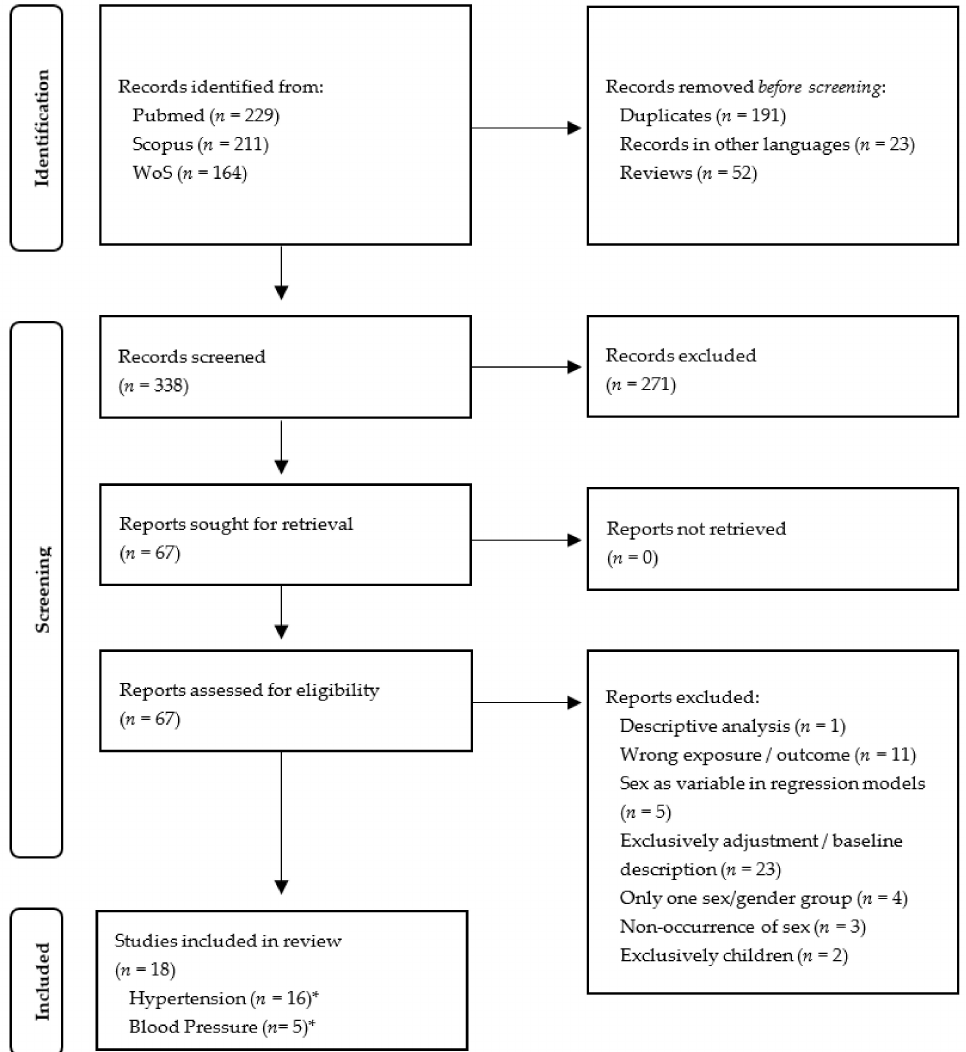
Figure 1. PRISMA Flow Diagram of the selection process of records regarding hypertension and blood pressure-changes. * Three studies investigated both outcomes hypertension and blood pressure-